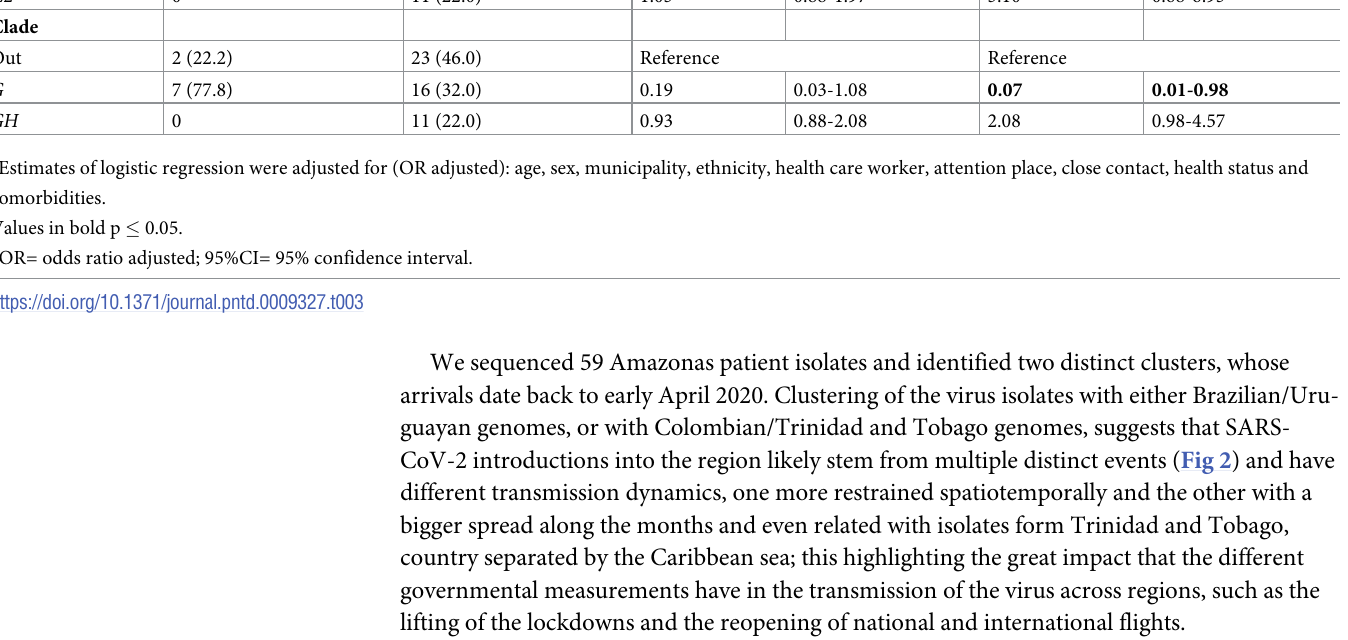
We sequenced 59 Amazonas patient isolates and identified two distinct clusters, whose arrivals date back to early April 2020. Clustering of the virus isolates with either Brazilian/Uru- guayan genomes, or with Colombian/Trinidad and Tobago genomes, suggests that SARS- CoV-2 introductions into the region likely stem from multiple distinct events ( Fig 2 ) and have different transmission dynamics, one more restrained spatiotemporally and the other with a bigger spread along the months and even related with isolates form Trinidad and Tobago, country separated by the Caribbean sea; this highlighting the great impact that the different governmental measurements have in the transmission of the virus across regions, such as the lifting of the lockdowns and the reopening of national and international flights.